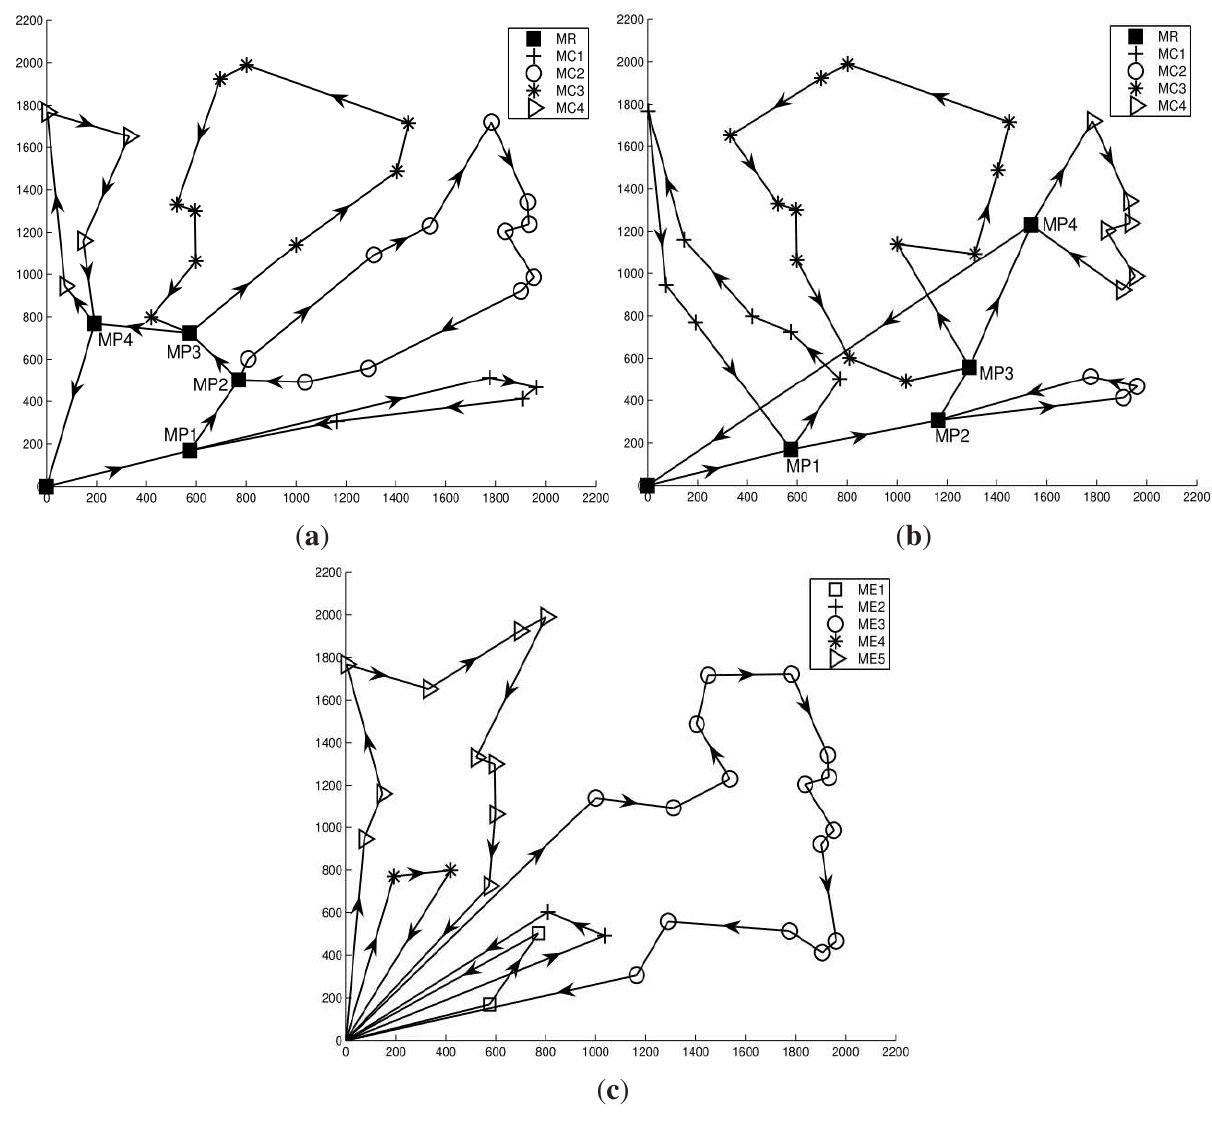
Figure 8. Movement paths of mobile elements. ( a ) Path by HiCoDG with SPG; ( b ) Path by HiCoDG with K-means; ( c ) Path by mTSP.